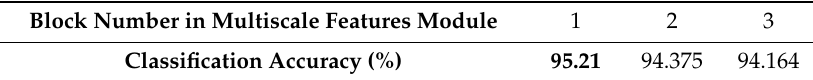
Table 6. The accuracy of the Google dataset of SIRI-WHU with di ff erent convolution block numbers in the multiscale feature extraction